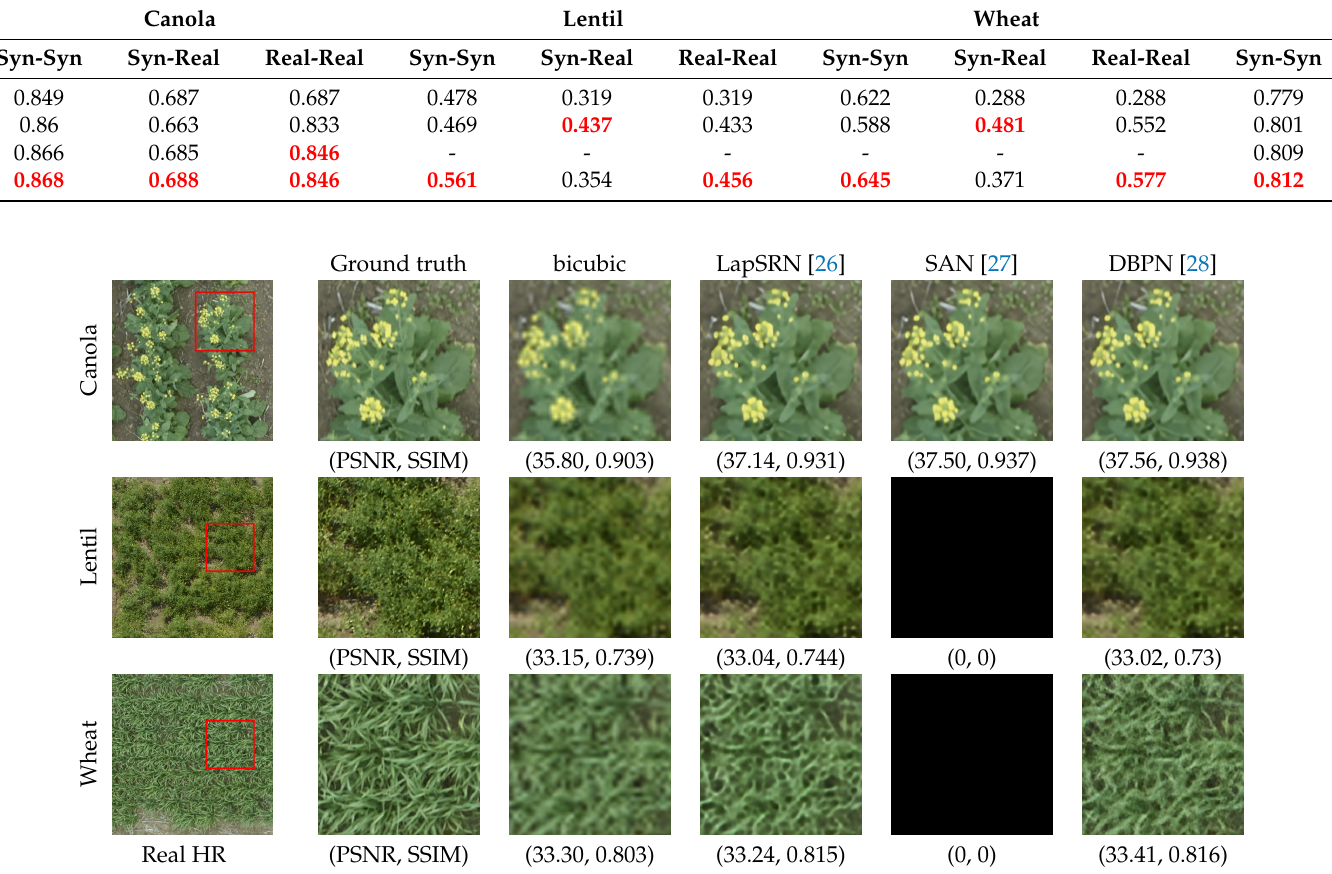
Figure 4. Example test images from the synthetic-synthetic experiment for canola, lentil and wheat datasets (top/middle/bottom rows). Ground truth HR images (left) are shown with the cropped region denoted by a red box. PSNR and SSIM values are listed below each image. Black images for SAN denote that the model failed to converge when trained on the lentil and wheat datasets.